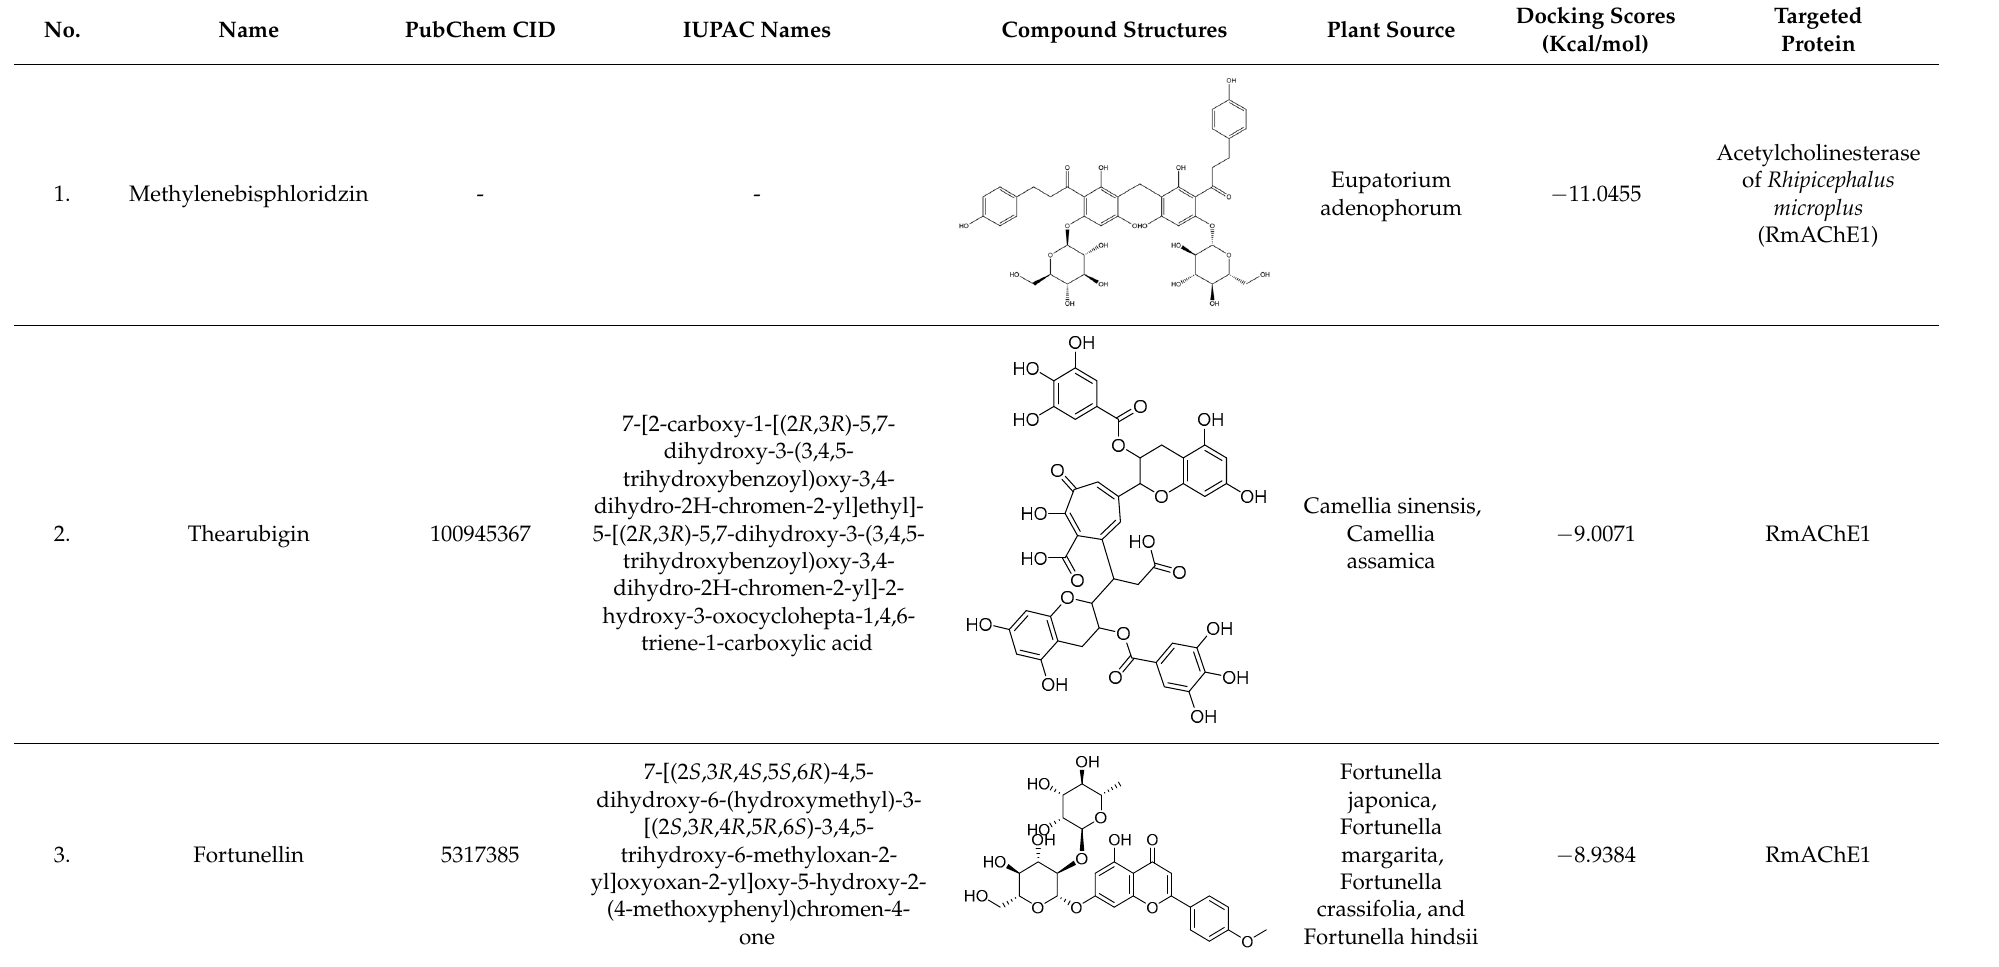
Table 1. Selected flavonoid molecules downloaded from PubChem and PubMed with maximal docking